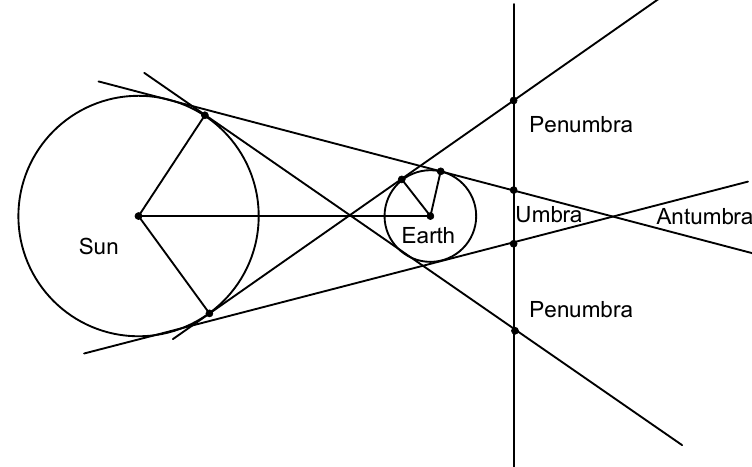
Figure 6. Schematic diagram of conical shadow model.